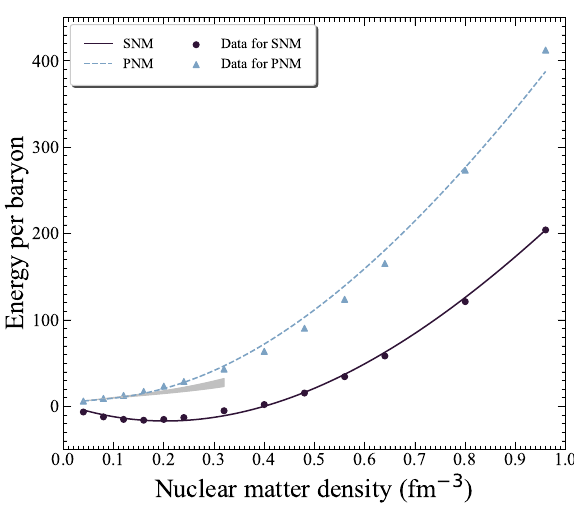
Figure 1. The fits of SNM and PNM of MDI + APR1 cold EoS. The SNM is presented by the circles and solid line, while the PNM is presented by the triangles and dashed line. The shaded region corresponds to benchmark calculations of the energy per particle of PNM extracted from Piarulli et al. [16].